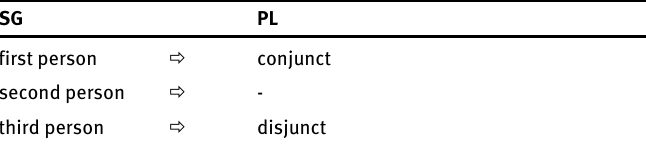
Table 6: Proposed reanalysis of person